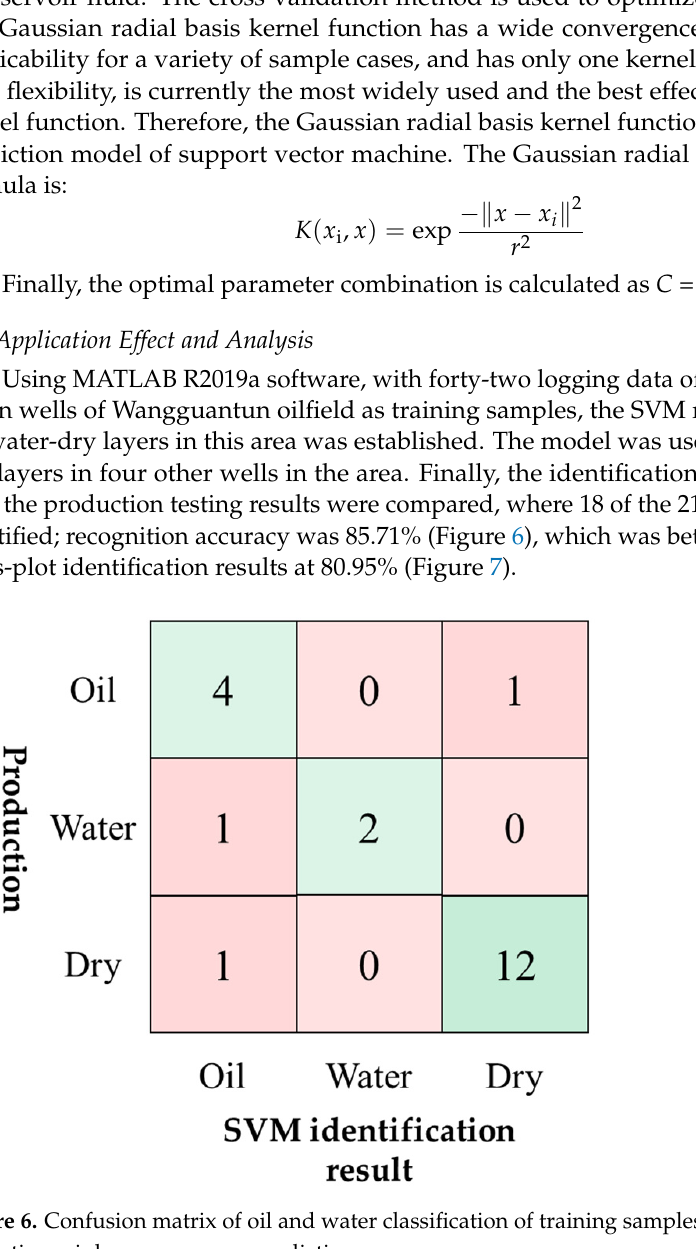
Figure 7. Crossplot of AC and RT of thin oil layer of Es33.